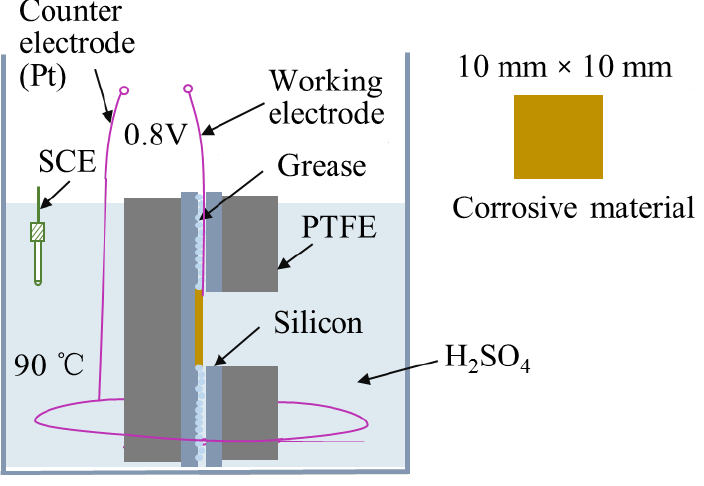
Figure 2. Schematic diagram of corrosion test.